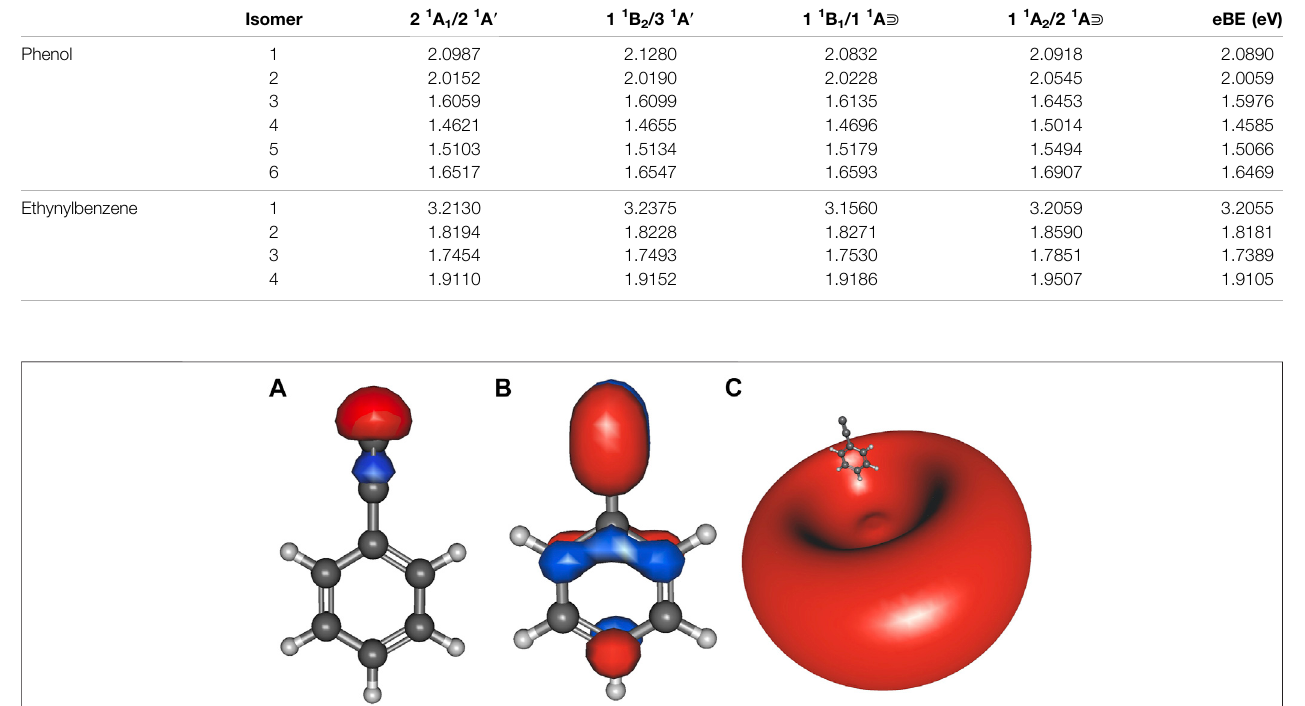
FIGURE 2 | Ethynylbenzene anion 1 a 1 HOMO-2 (A) ; b 1 HOMO (B) , and the a 1 LUMO (C) dipole-bound orbital.